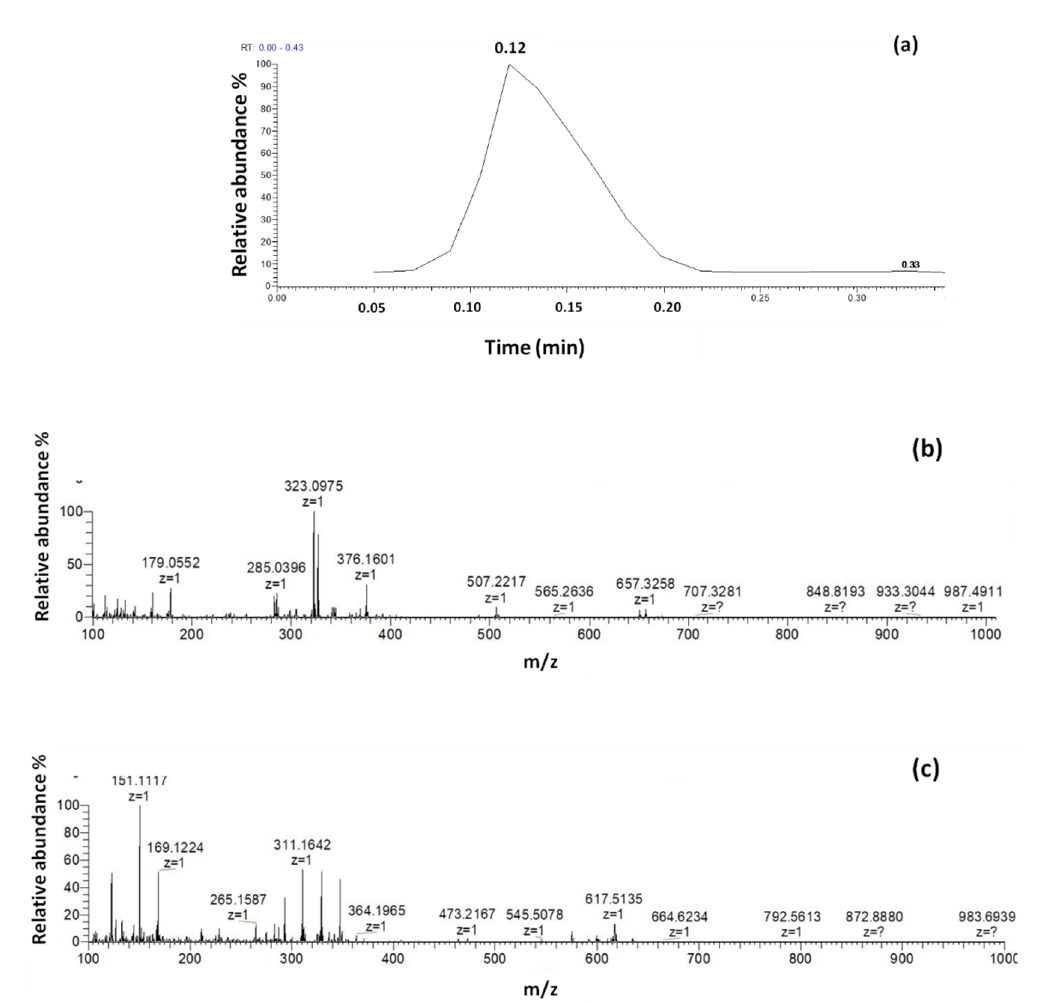
Figure 1. Chronogram ( a ) along with mass spectra obtained by DART-HRMS analysis of pure saffron in negative ( b ) and positive ( c ) ion mode acquisition with the optimized conditions.